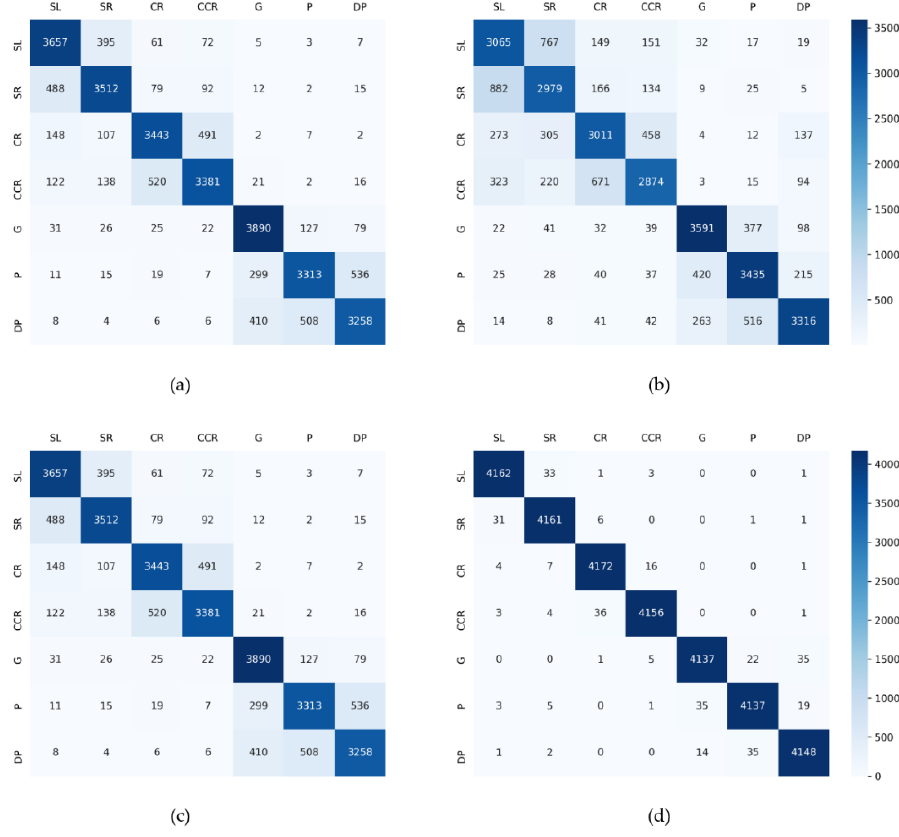
Figure 19. The confusion matrices of each machine learning for the source domain dataset. ( a ) RNN; ( b ) 2D-CNN; ( c ) 3D-CNN without domain discriminator; ( d ) 3D-CNN.